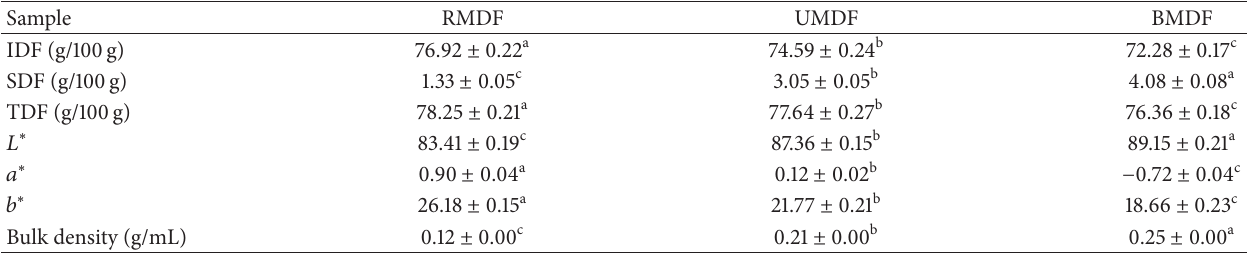
Figure 3: Scanning electron micrographs (1000x) of different IDF fractions: (a) regular milled IDF fraction, (b) ultra centrifugal milled IDF fraction, and (c) ball milled IDF fraction. Table 1: Effects of grinding on physicochemical properties of IDF